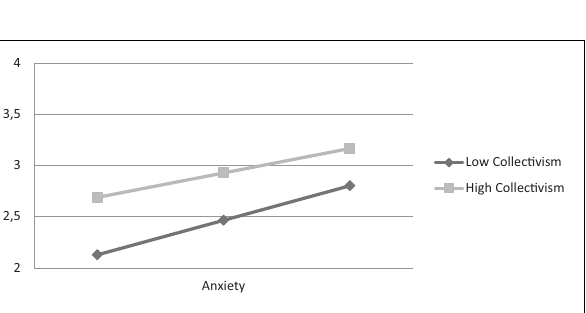
FIGURE 1 | Effect of anxiety on passive-submissive coping style is moderated by individualism.